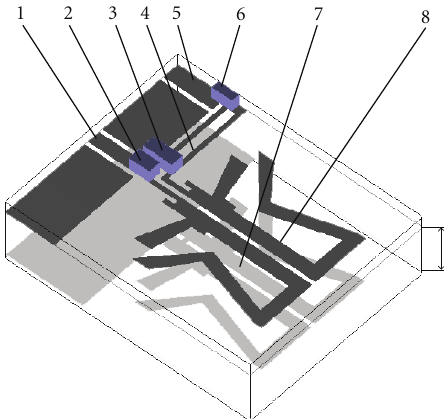
Figure 9: Antenna configuration with PIN diode.